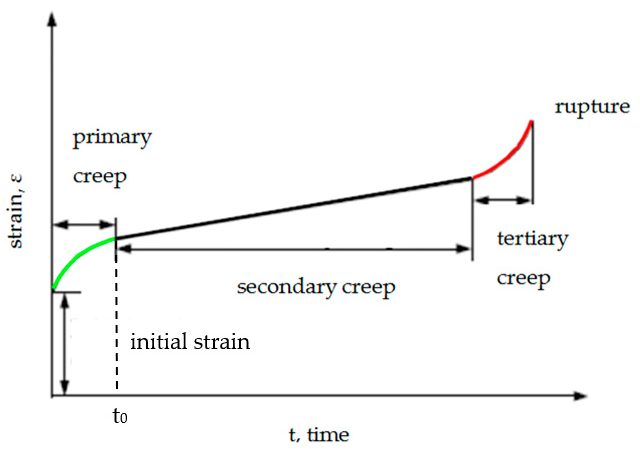
Figure 4. The creep process in the function of time [9].